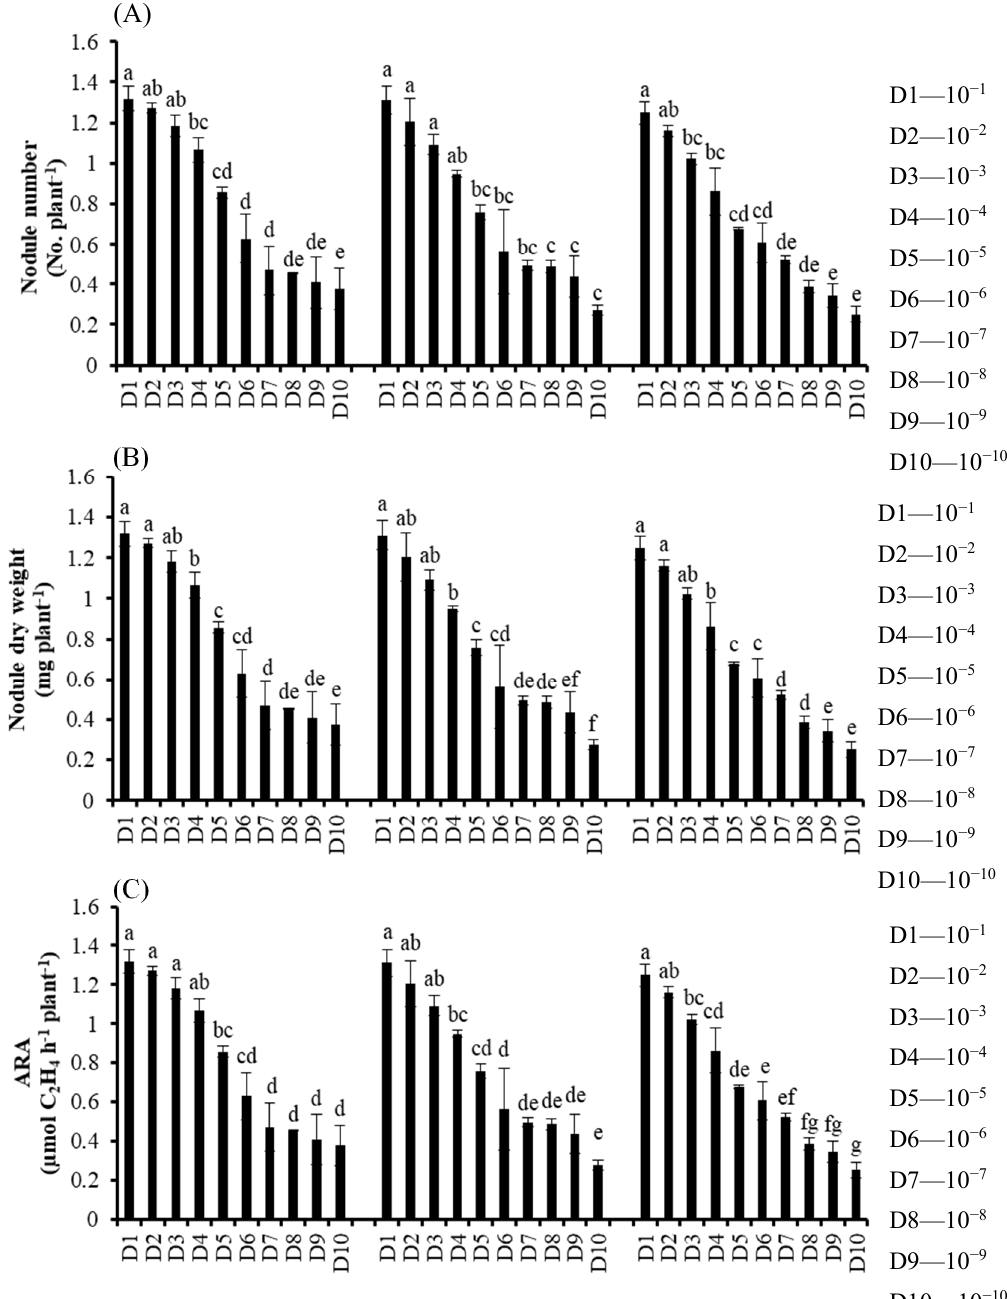
Figure 1. Effect of different dilution times of biofertilizer produced from B . japonicum SAY3-7 (type A), B . elkanii BLY3-8 (type B) and S. griseoflavus P4 on ( A ) nodule number, ( B ) nodule dry weight ( C ) nitrogen fixation in terms of ARA of Yezin-6 soybean varieties at 30 days after sowing. The histograms with the same letter are not significantly different at p < 0.05 (Tukey’s test). The bar on each histogram indicates SD.